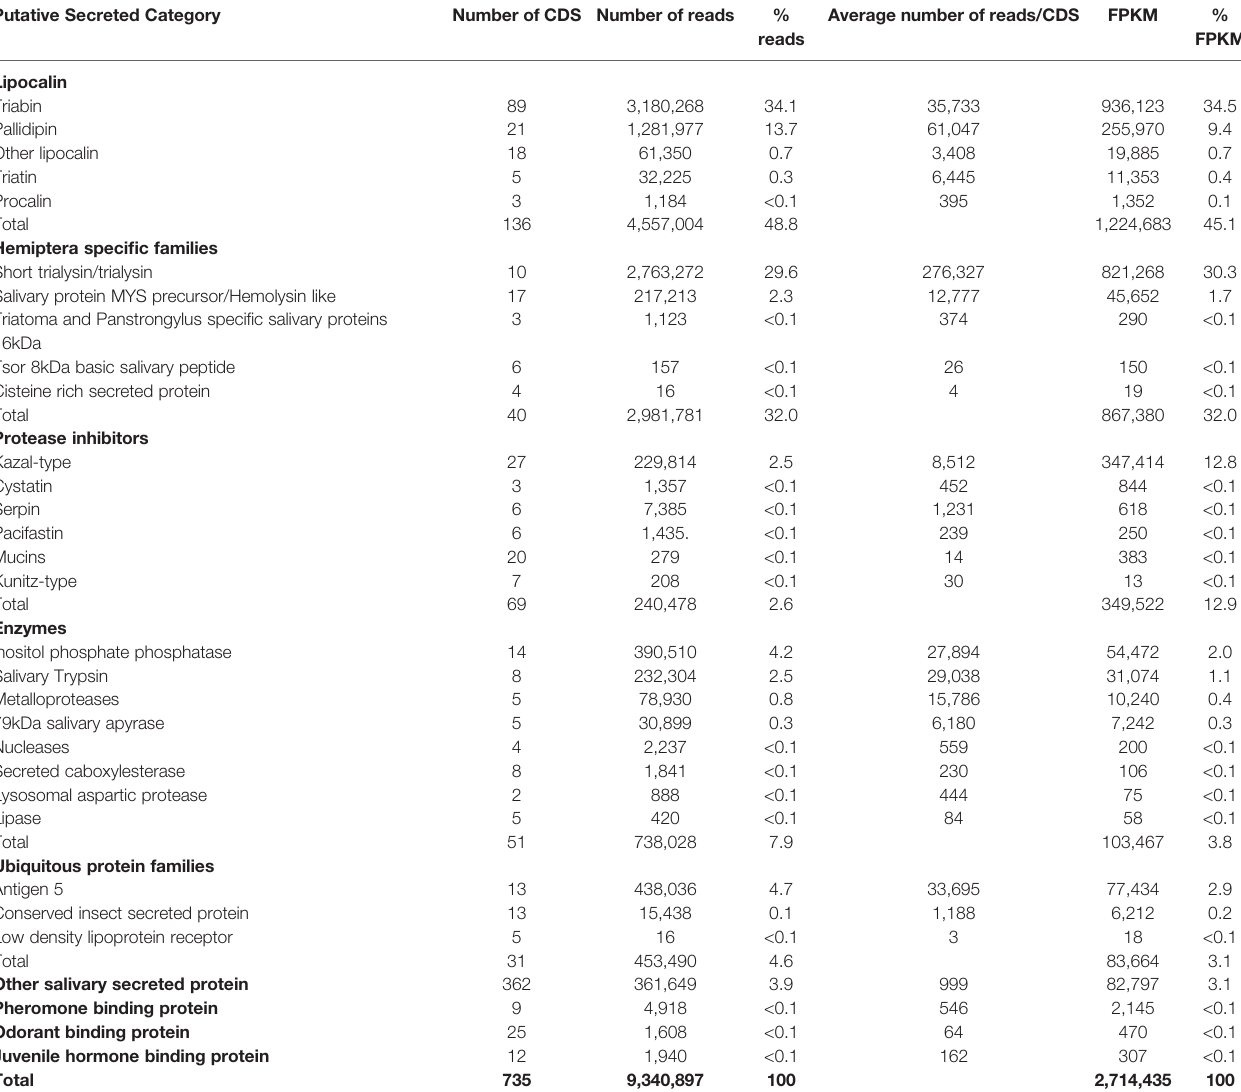
TABLE 3 | Functional classi fi cation and expression levels of the CDS attributed to the putative Secreted category extracted from Triatoma sordida sialotranscriptome. Putative Secreted